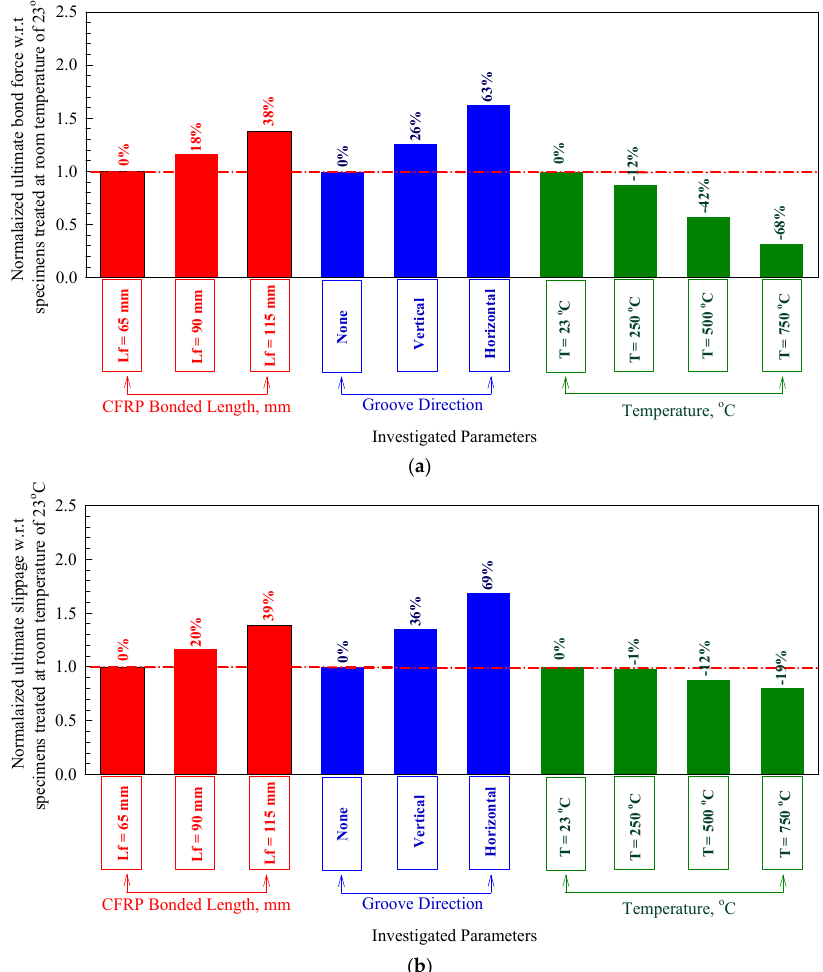
Figure 7. Normalized ultimate bond force and slippage. ( a ) Ultimate bond force; ( b ) ultimate